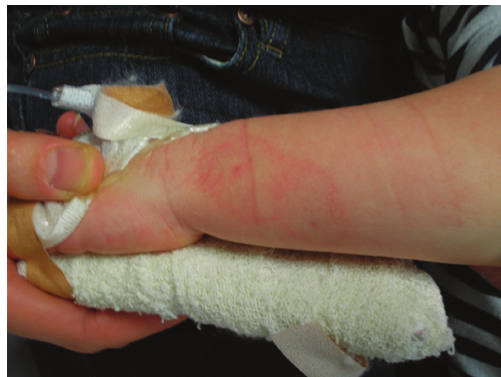
Figure 1: Bite marks on patient’s skin.